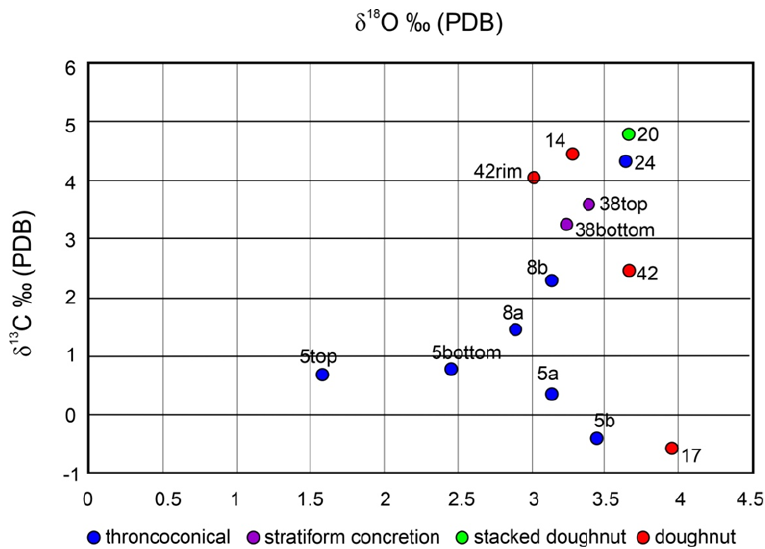
Figure 7. Stable carbon (δ 13 C) and oxygen (δ 18 O) isotope ratios plot for selected conduit concretions from the Paglia riverbed. Numbers and shapes used are the same as in Table 1. Isotopic values are reported in Table 3 ( δ 13 C and δ 18 O values relative to the different morphologies of carbonate concretions).